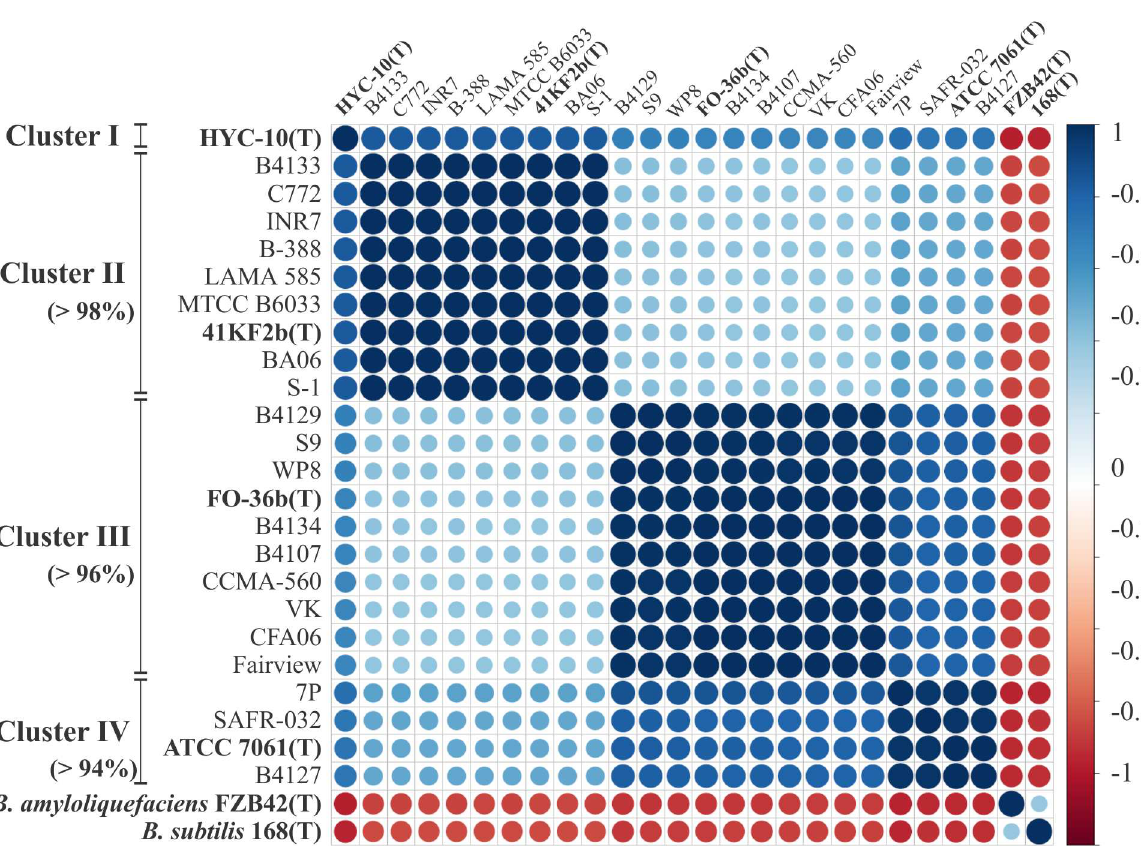
Fig 2. Correlation plot based on strain ANI values. ANI values between each indicated strain (Types in bold) were calculated using the JSpecies software [14] and used for a Pearson correlationmatrix construction conductedusing R [19]. The plot shows the correlation constructed and ordered by hierarchical clustering using the R package “corrplot” [20]. The minimum percentages of ANI values between strains of a given cluster are indicatedin